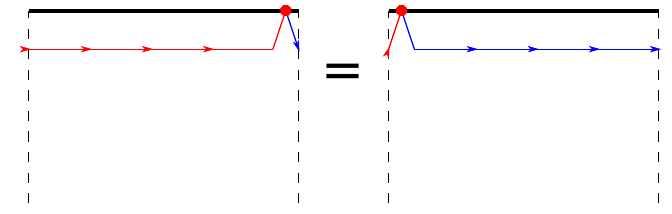
Figure 3 . The KT -equation. The red curve corresponds to the holonomy of A ( λ ) and the blue curve corresponds to the holonomy of A β ( − λ )